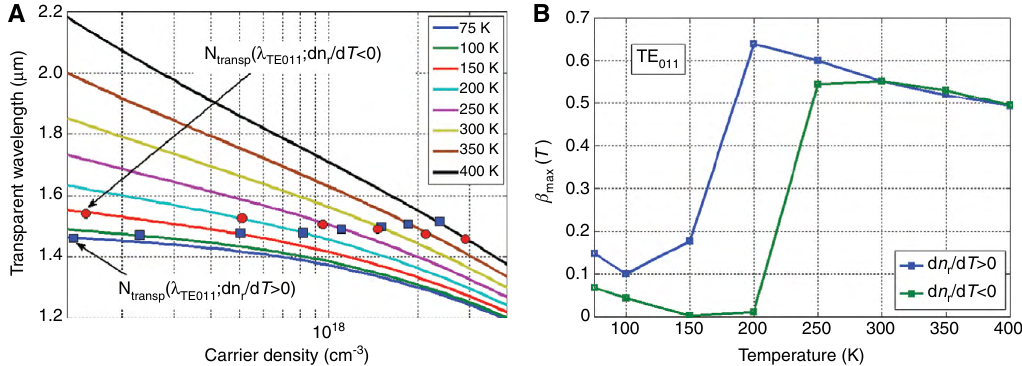
Figure 5 (A) Transparent wavelength versus carrier density and (B) spontaneous emission factor versus temperature for MQW InGaAsP metal- clad nanolasers. The cases of positive and effectively negative TOCs are denoted by d n